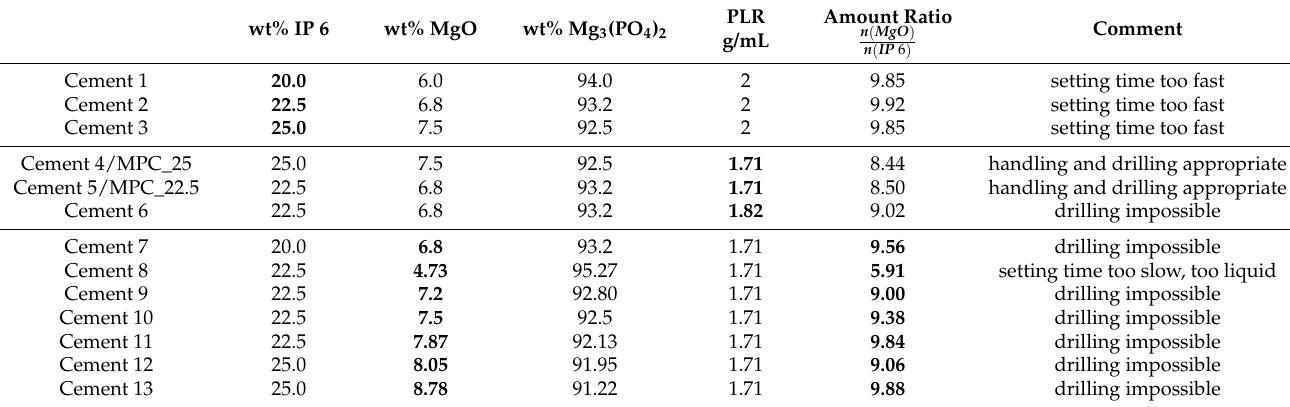
Table 1. Overview of the chemical composition of all evaluated magnesium phosphate cement (MPC) formulations. wt% = weight percent; PLR = powder to liquid ratio; n = amount of substance (mol). wt% IP 6 wt%